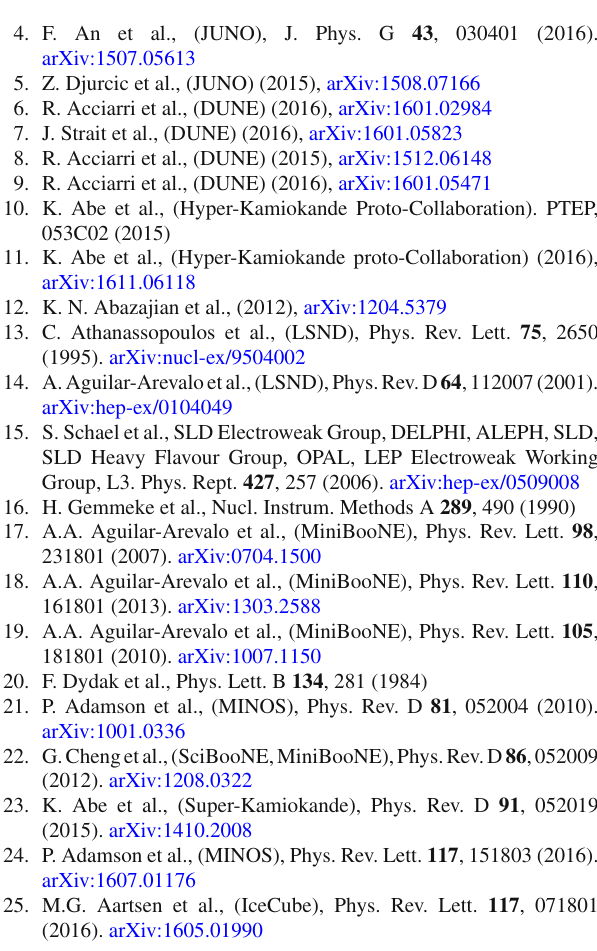
would result in one or more fake islands appearing in the (cid:2) m 2 allowed CL contours coming from the appearance 41 channel of long-baseline experiments. The disappearance channel does not have any such fake